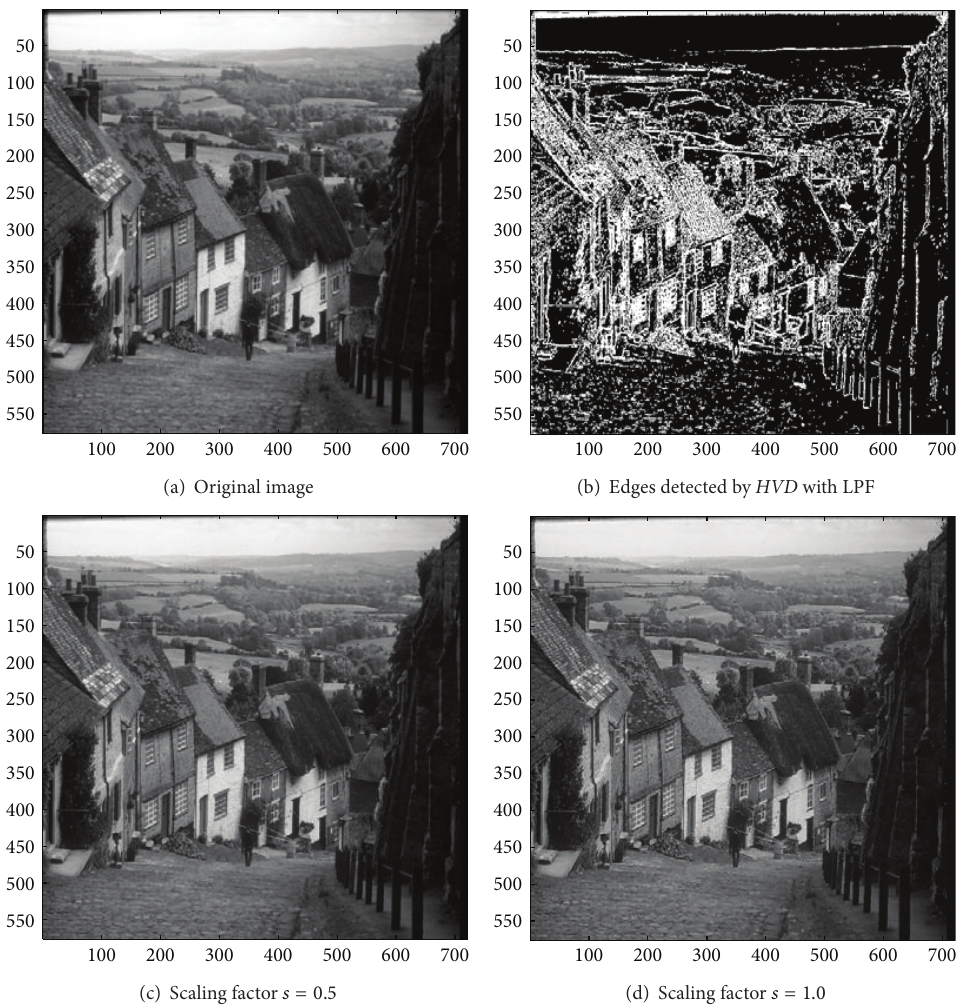
= 10 for HVD . (a) The image “Goldhill” (720 × 576 grey image). (b) Edges detected by HVD with LPF. (c and d) Sharpened Figure 16: 𝜃 eth results by HVD with scaling factors 0.5 and 1.0 ,